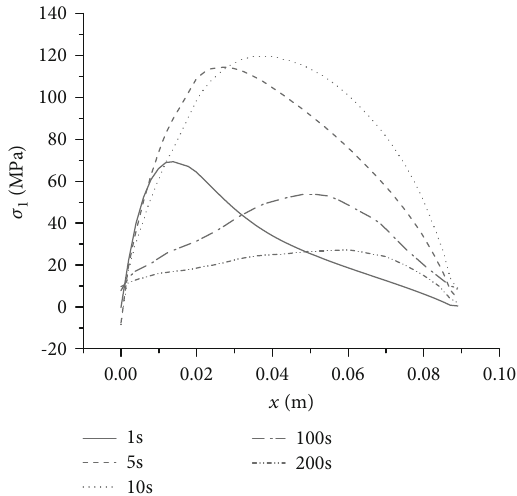
ff ect of the Mach number on the peak of maximum principal